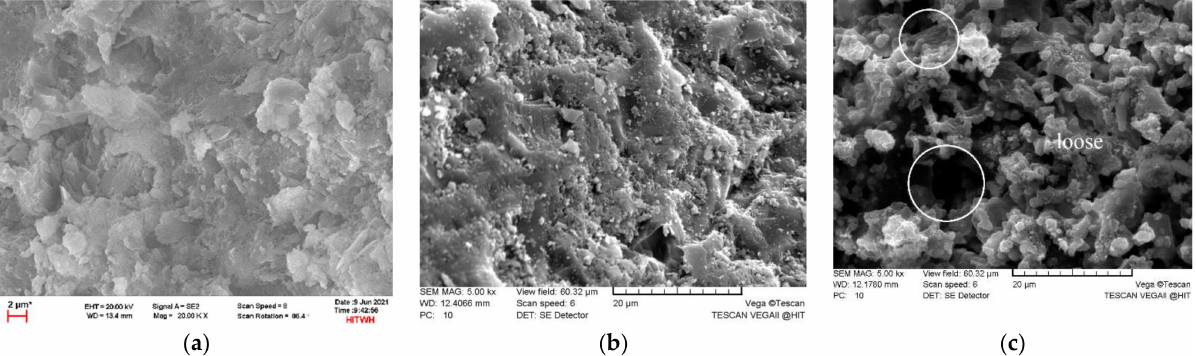
Figure 9. SEM images of the graphene concrete in different corrosion humidity: ( a ) no corrosion, ( b ) humidity 71% (time 21 days), and ( c ) humidity 85% (time 35